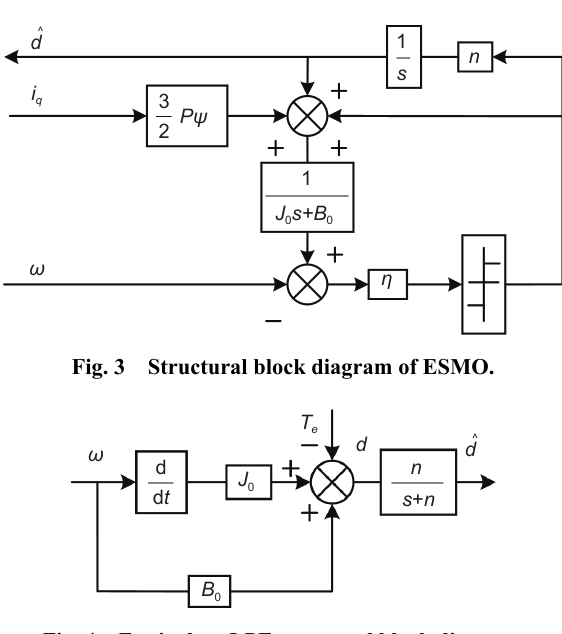
Fig. 4 Equivalent LPF structural block diagram.